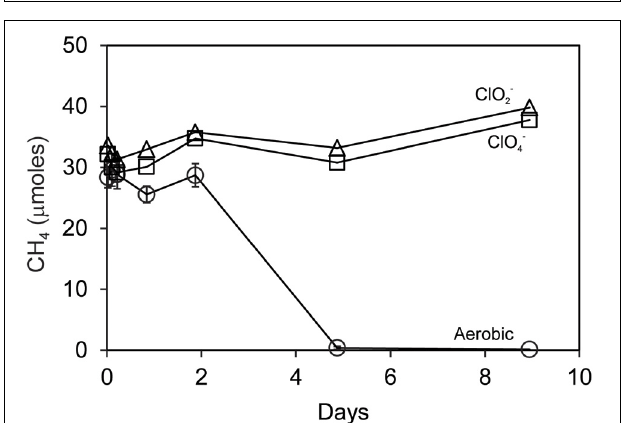
FIGURE 6 | Methane uptake by Searsville Lake sediment slurries pre-adapted to reduce perchlorate using acetate as electron donor. Anaerobic incubations with 5mM added ClO − 4 (squares) or ClO − 2 (triangles) showed no uptake. Aerobic incubations (circles) represent the mean and standard deviation of CH 4 measurements in all bottles aerobic.